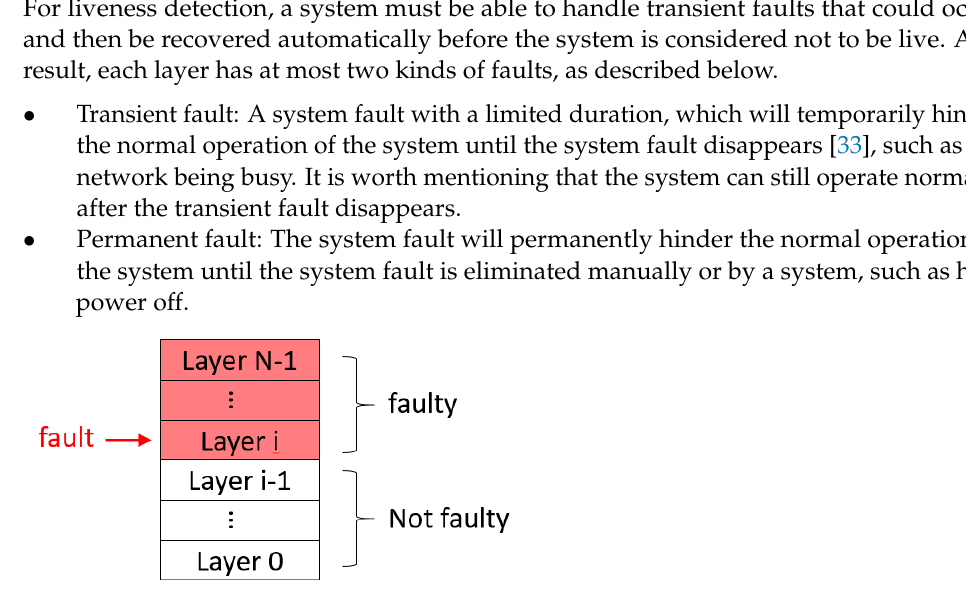
Figure 2. The impact of a system fault on a multi-layer system with the layer dependency